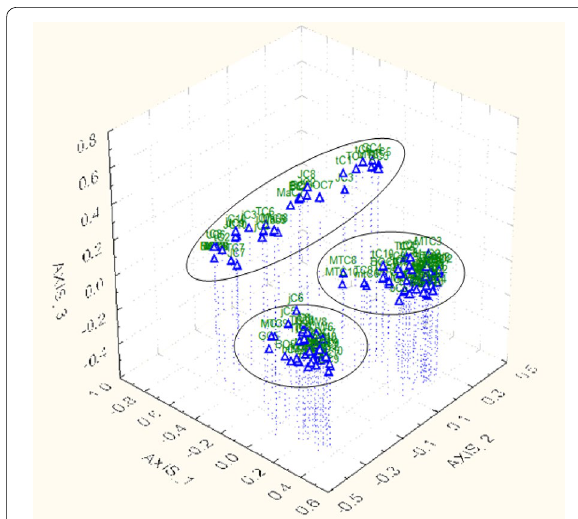
Fig. 6 Three dimensional representation (3D) of principal coordinate analysis of genetic relationships among 129 individuals of Aframo- mum corrorima from southwestern part of